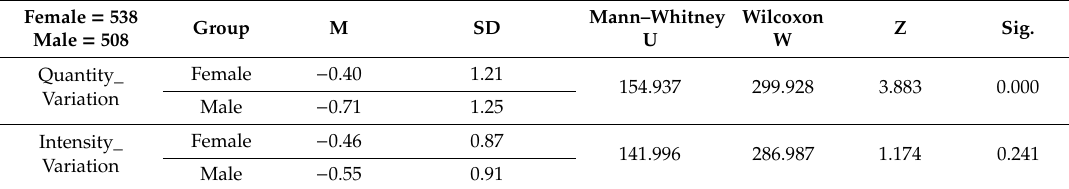
Table 5. Comparison of the variation between men and women, before and during the confinement, in quantity and